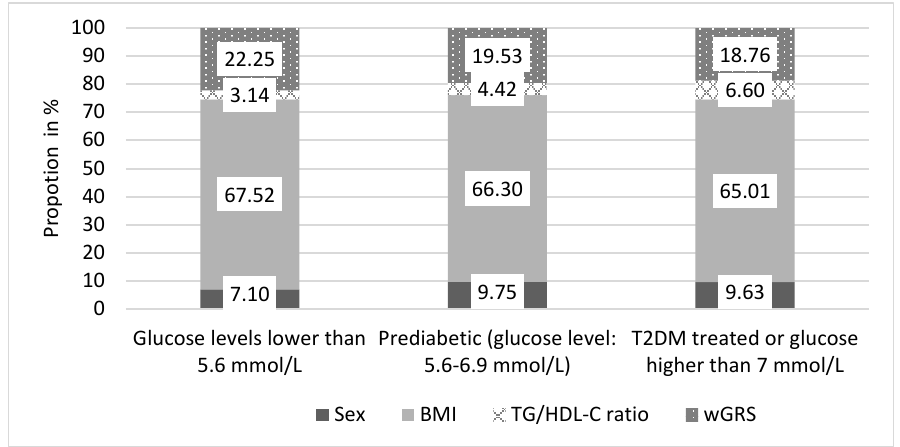
Figure 4. The proportion of components (sex, BMI, TG/HDL-C ratio, and wGRS) of the age of onset risk score in the Hungarian general population by subpopulations.